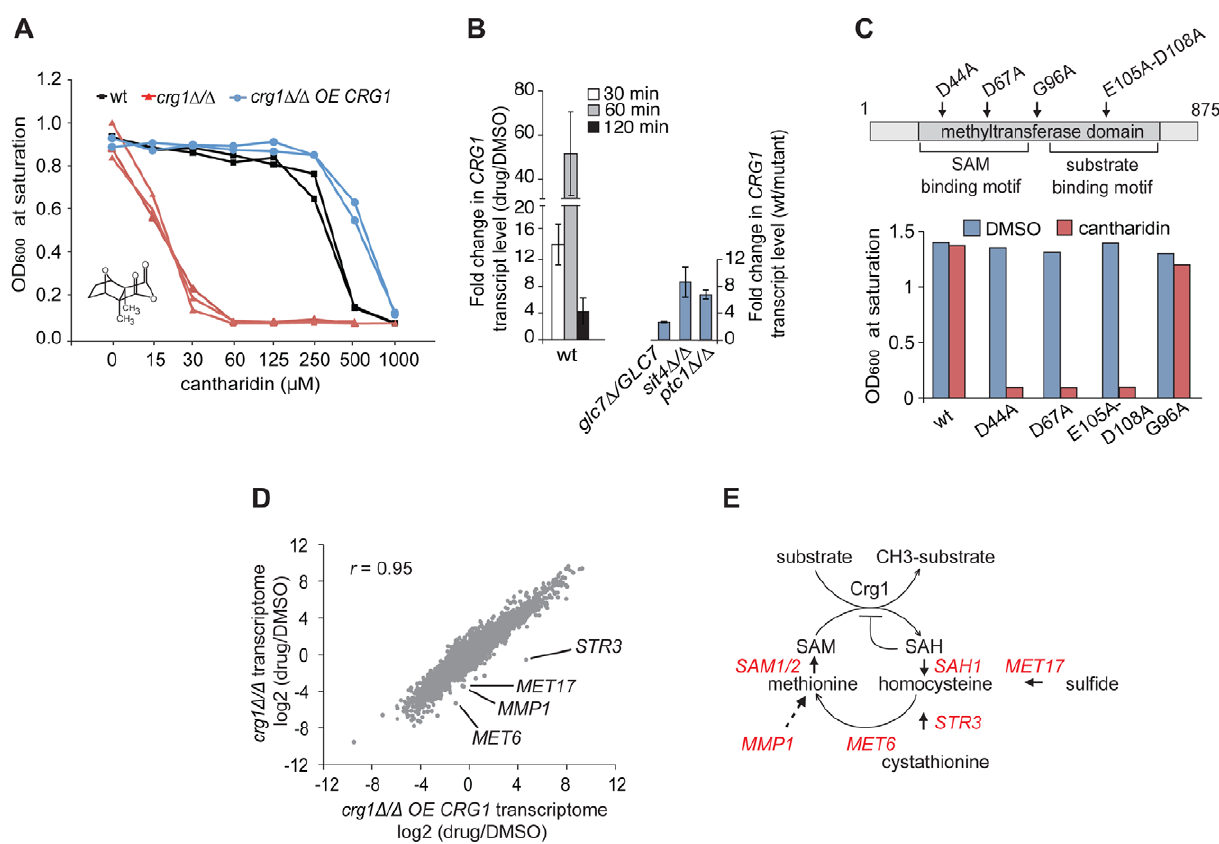
Figure 1. Functional SAM-dependent methyltransferase Crg1 is required for cantharidin response. (A) CRG1 gene dose is important for cantharidin tolerance. Wt, crg1 D / D and CRG1 -overexpressing crg1 D / D mutants were assessed in the presence of cantharidin in YPD. Dose-response curves were obtained by plotting OD 600 at saturation point vs. tested drug concentrations. (B) Chemical (left panel) and genetic inhibition (right panel) of protein phosphatases result in the induction of CRG1 . Wt, glc7 D /GLC7 heterozygous, sit4 D / D and ptc1 D / D homozygous deletion mutants grown to mid-exponential phase were incubated with or without cantharidin (250 m M). For each time point, total RNA was extracted, cDNA synthesized and the relative abundance of CRG1 transcript was analyzed by qRT-PCR. Data are the mean of at least three independent experimental replicates, and error bars represent the standard deviation. (C) Point mutations in conserved residues of the Crg1 methyltransferase domain reduce cantharidin tolerance. Site-specific mutations in the conserved motifs of methyltransferase domain are shown with the arrows. Mutated CRG1 ORFs were cloned under GAL1 promoter and transformed into crg1 D / D cells. The transformants were grown in SD-URA with raffinose (2%) to mid- exponential phase and induced with galactose (2%). The fitness of point mutants based on saturation at final OD was assessed in the presence of cantharidin (6 m M). (D) A plot comparing the transcriptome profiles of crg1 D / D and CRG1 -overexpressing crg1 D / D mutants. Exponentially grown cells were treated with cantharidin (250 m M) for 1 hour or DMSO, total RNA was extracted and synthesized cDNA was hybridized to Affymetrix Tiling arrays. Significantly different GO Biological processes are listed in Table S1. (E) Diagram showing that the methionine biosynthesis is tightly linked to SAM cycling in methylation reactions coordinated by methyltransferases. The genes that are transcriptionally different between cantharidin-resistant and sensitive mutant are shown in red. STR3 ( P -value , 0.0057), MET17 ( P -value , 0.0036), MET6 ( P -value , 0.012), SAM1 ( P -value , 0.02), SAH1 ( P -value , 0.03), MMP1 ( P -value , 0.04), SAM2 ( P -value , 0.056) (Table